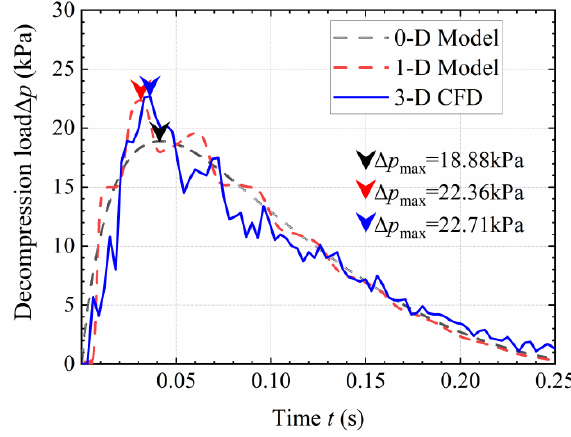
Figure 11. Curves of decompression load (3D-CFD verification).